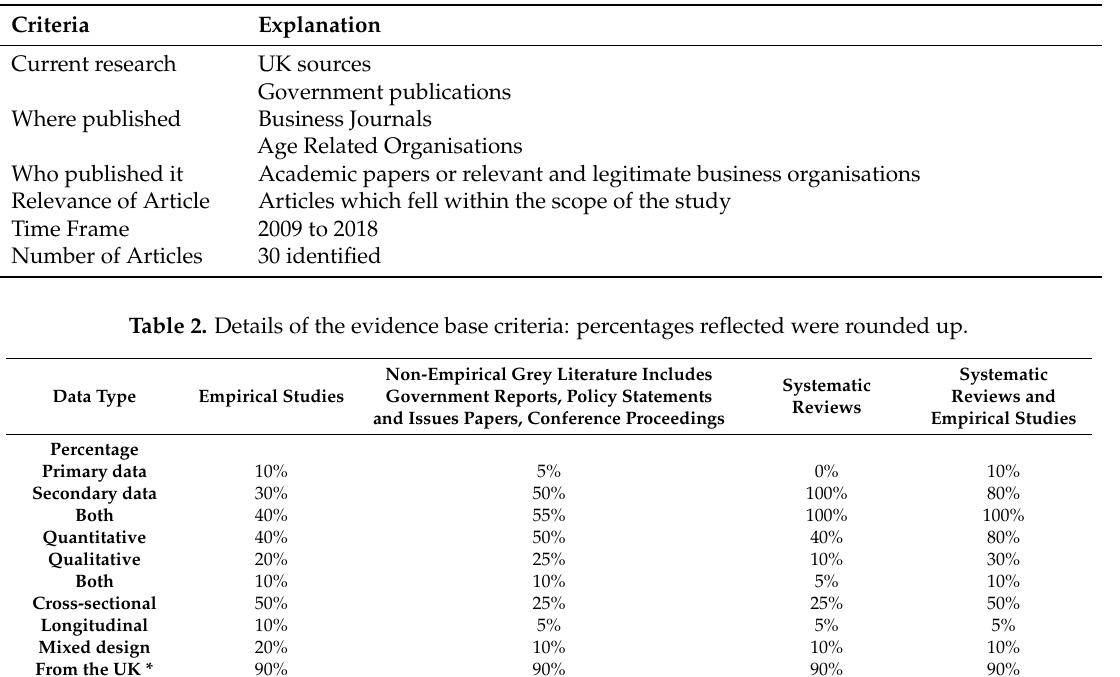
Table 1. Criteria for article selection.